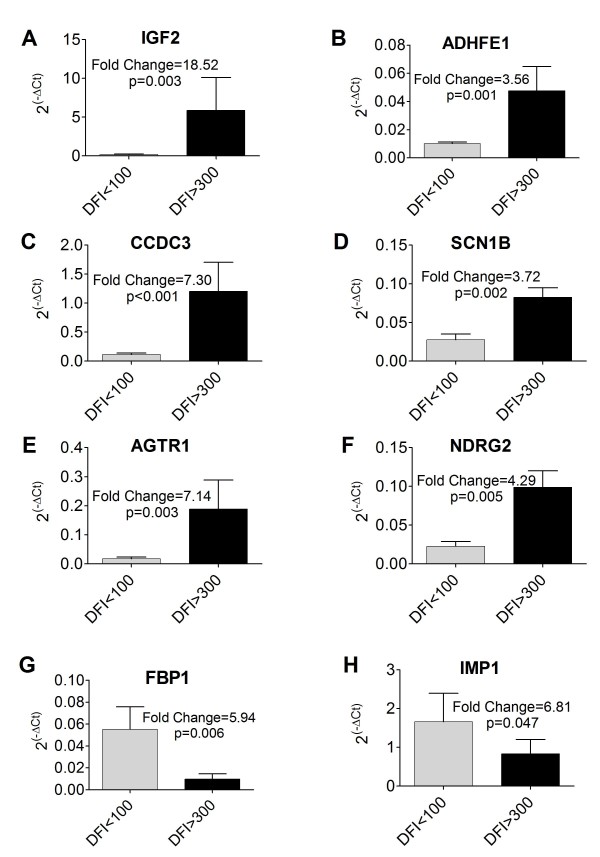
qRT-PCR validation of genes selected from fold change analysis of microarray data. Expression represented as 2(-ΔCt) for eight genes selected from fold change analysis of gene array data that were significant on qRT-PCR validation with 20 samples. Higher values indicate higher expression between cohorts and among genes. Fold change and p-values calculated via the REST2009 method. Error bars represent standard error. Insulin-like growth factor II (IGF2, A), alcohol dehydrogenase, iron containing 1 (ADHFE1, B), coiled-coil domain containing 3 (CCDC3, C), sodium channel, voltage-gated, type I, beta (SCN1B, D), angiotensin II receptor, type 1 (AGTR1, E), n-myc downstream-regulated gene family member 2 (NDRG2, F), fructose-1,6-bisphosphatase 1 (FBP1, G), and IGF2 mRNA binding protein 1 (IMP1, H).